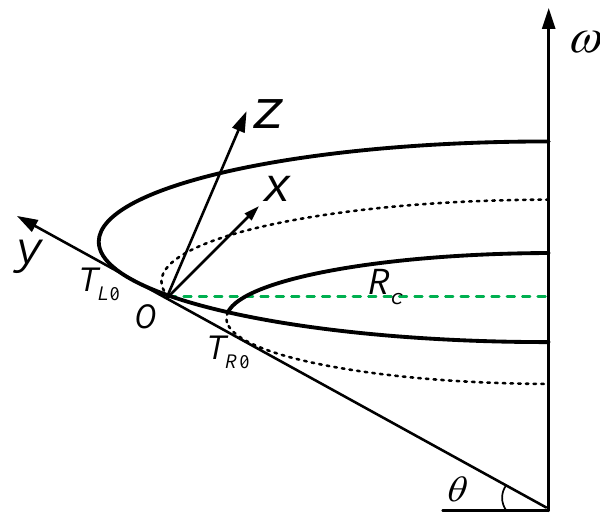
Figure 4. Sketch of horizontal curve